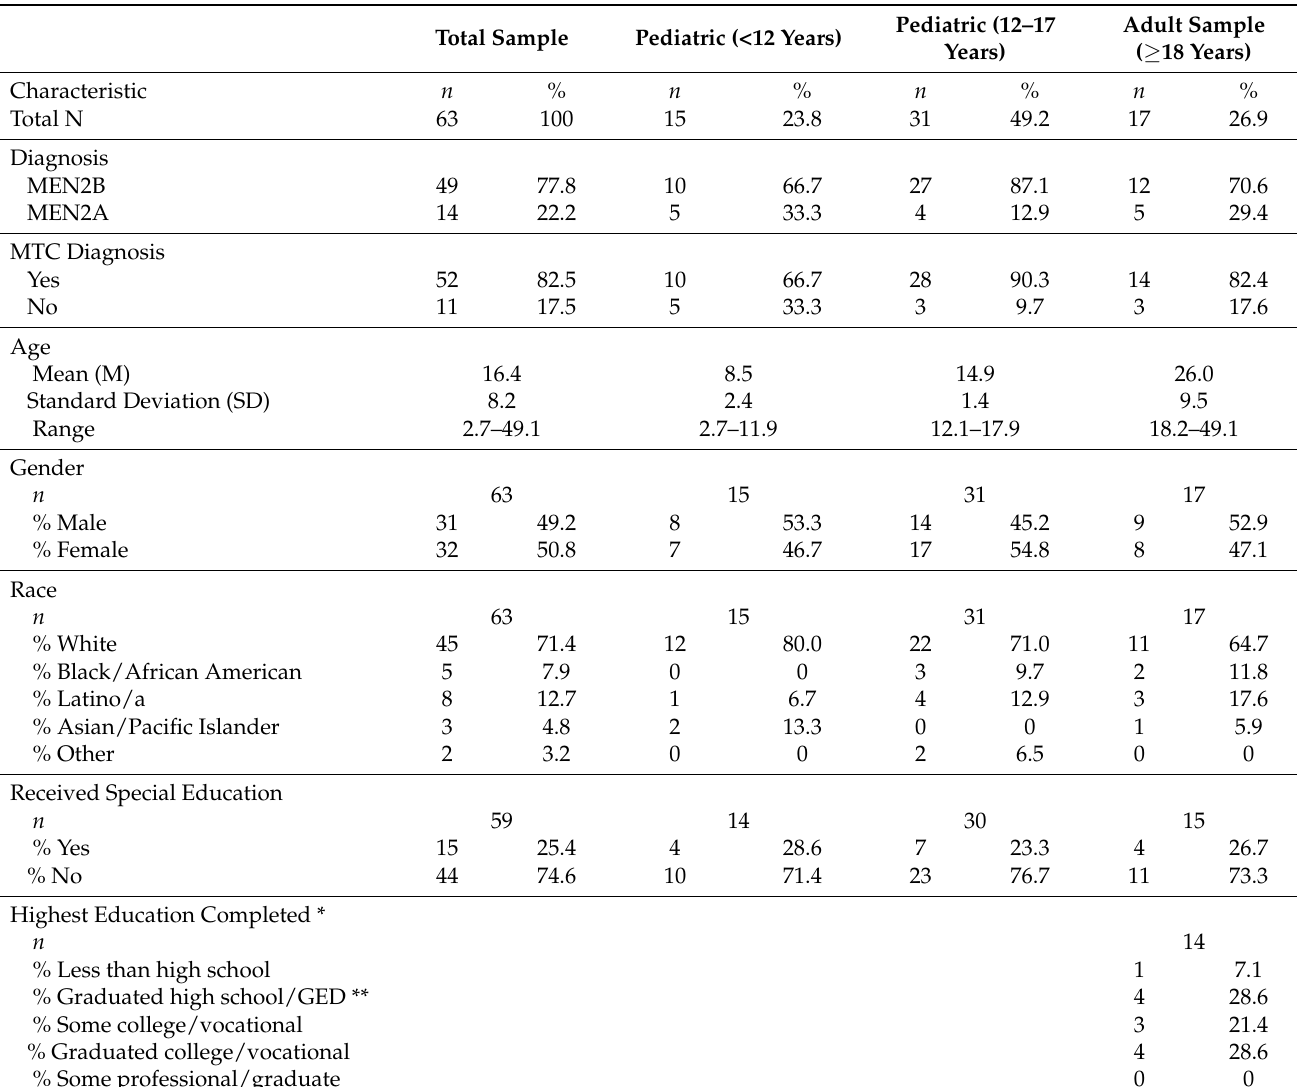
Table 1. Demographic characteristics of pediatric and adult patients with Medullary Thyroid Carci- noma